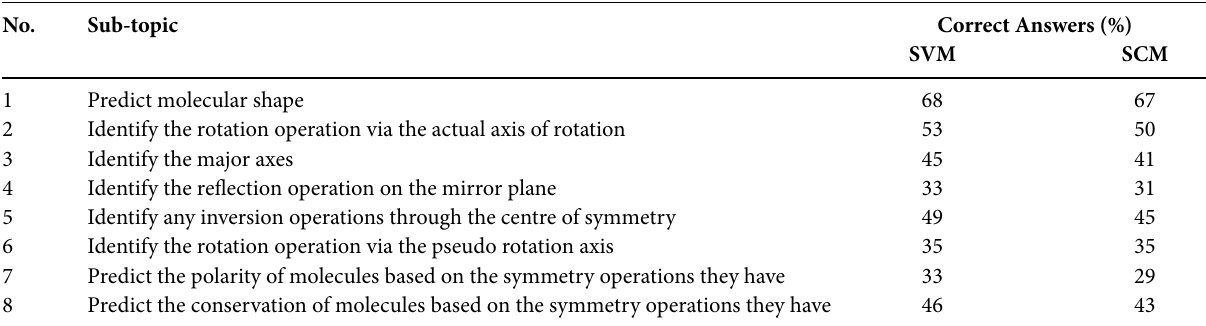
Table 3. The comparison of Correct Answers between SVM and SCM students No.